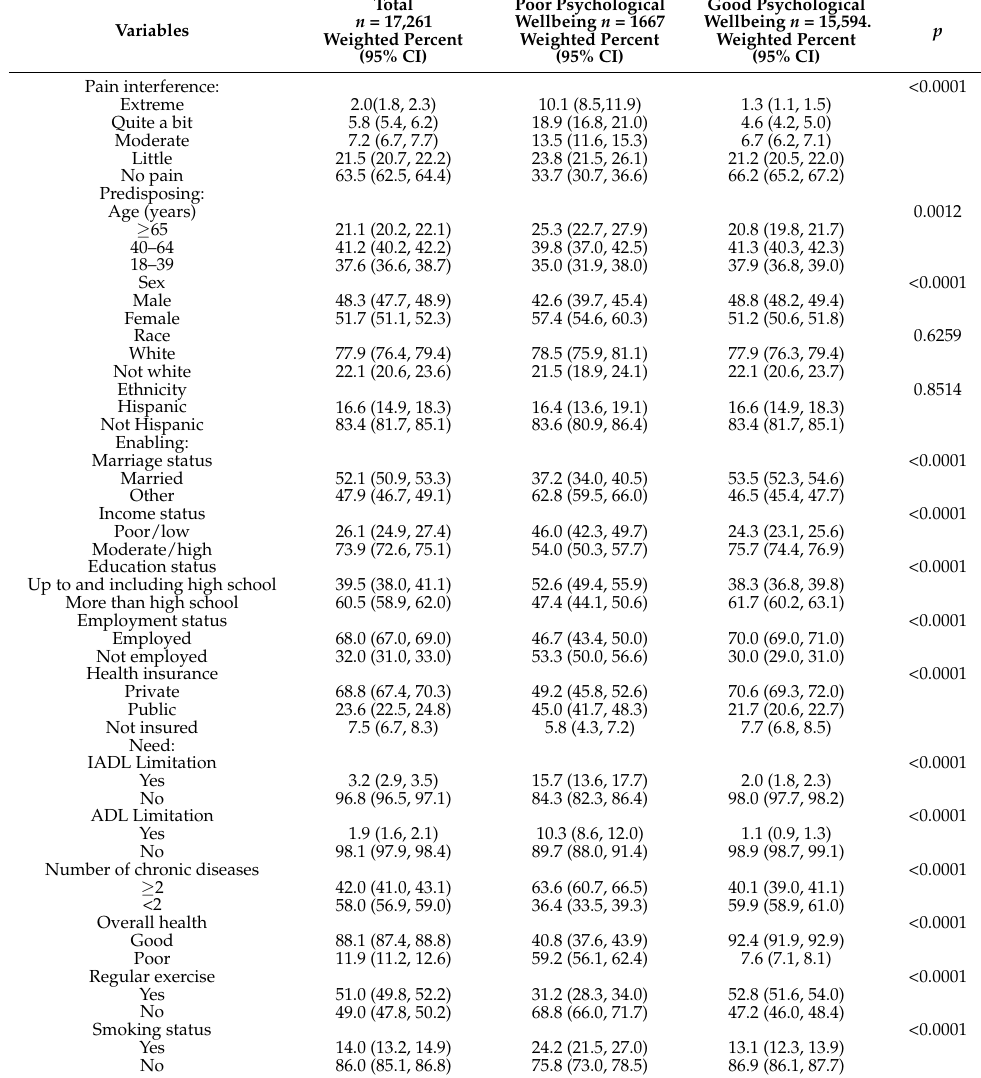
Table 1. Characteristics of United States adults stratified by poor vs. good psychological wellbeing. Total Poor Psychological Good Psychological n = 17,261 Wellbeing n = 1667 Wellbeing n = 15,594. p Variables Weighted Percent Weighted Percent Weighted Percent (95% CI) (95% CI) (95% CI) Pain interference: <0.0001 Extreme 2.0(1.8,